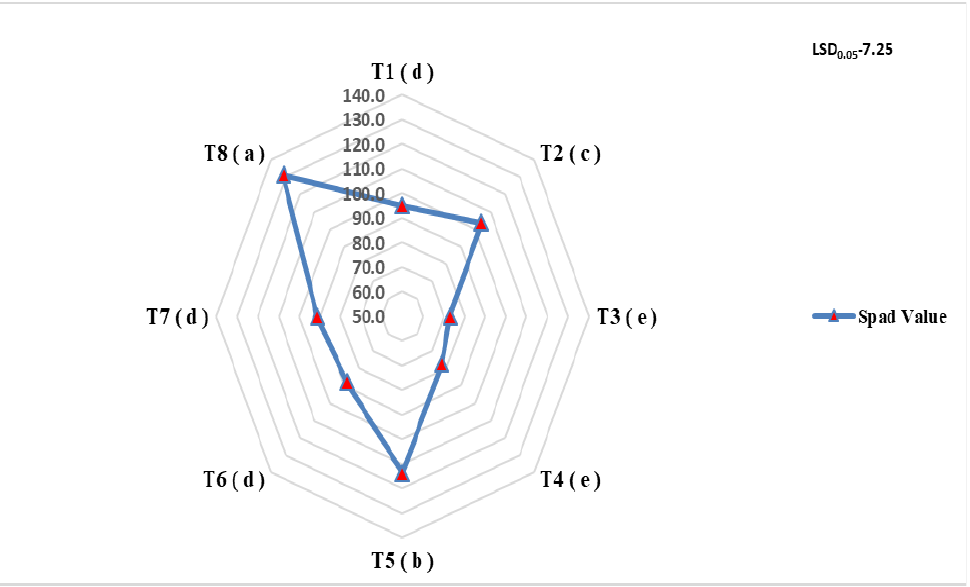
Figure 1. Impact of organic manures on leaf Spad values for Actinidia deliciosa cv ‘Allison’ .